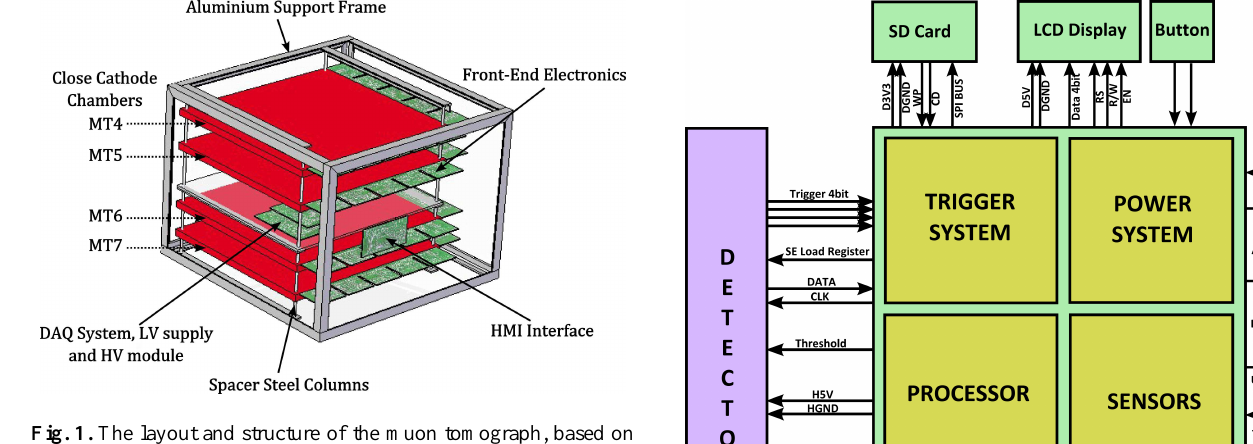
Fig. 1. The layout and structure of the muon tomograph, based on Barnaf¨oldi et al. (2012).